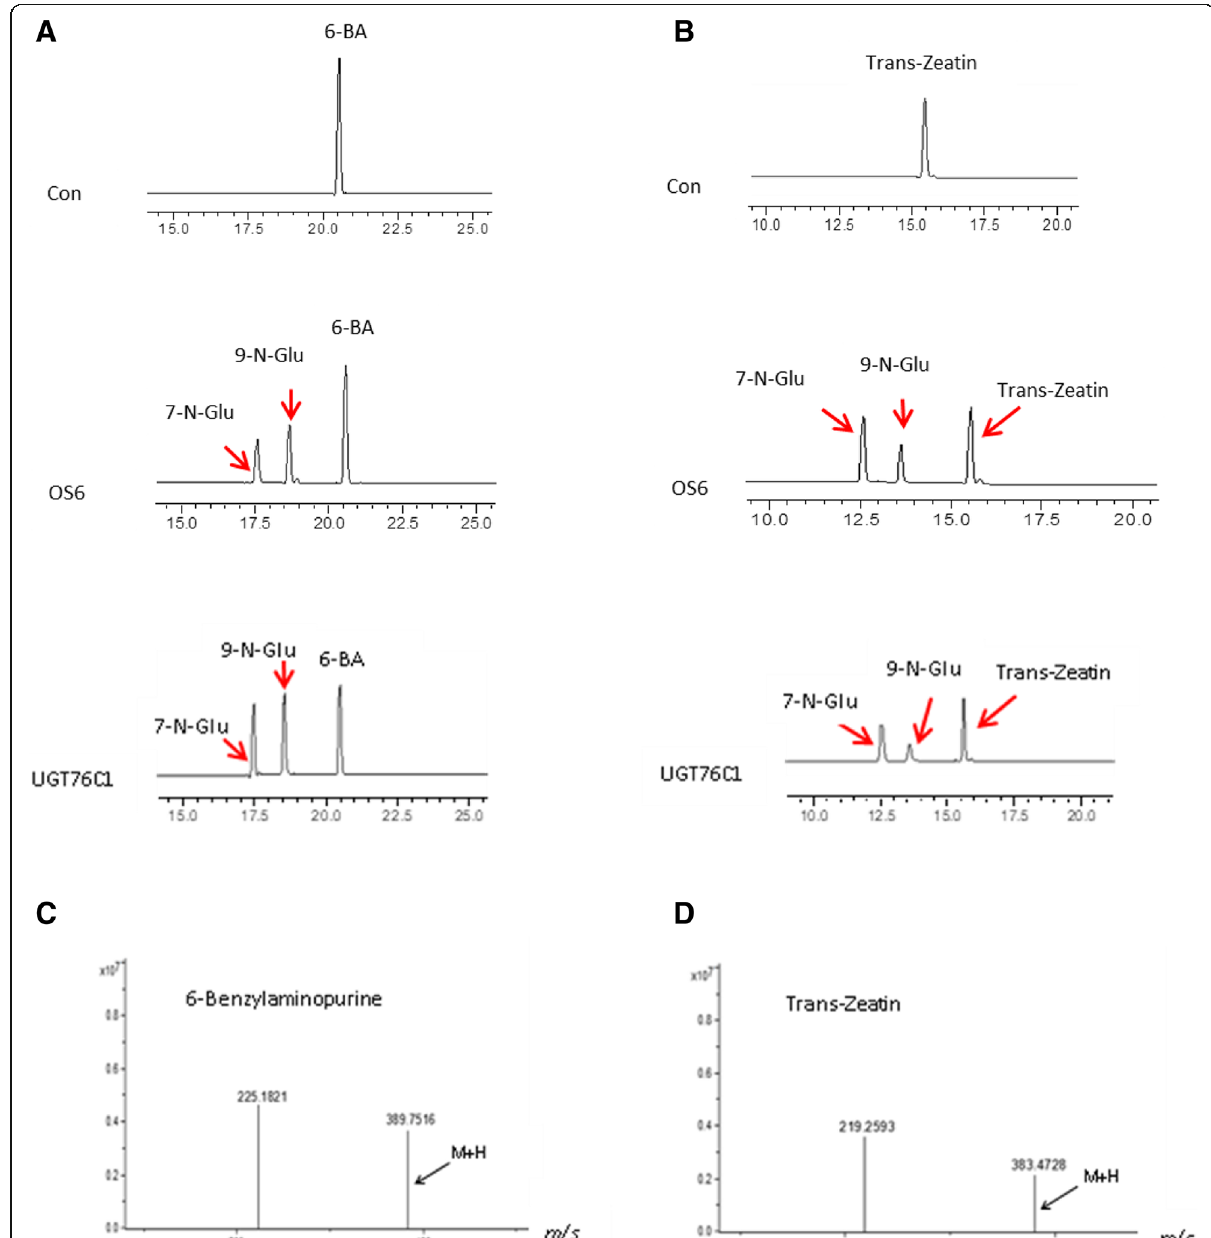
Fig. 5 Rice glycosyltransferase OS6 enzymatic reaction and substrate identification. OS6 can transfer glucose to two cytokinins, trans-zeatin and 6- Benzylaminopurine, which were detected by HPLC and LC/MS mass spectrometry. a . Rice glycosyltransferase Os6 can glycosyl 6-BA by HPLC. b . Rice glycosyltransferase Os6 can glycosyl tZ by HPLC. c . Rice glycosyltransferase Os6 can glycosyl 6-BA by LC/MS. d . Rice glycosyltransferase Os6 can glycosyl tZ by